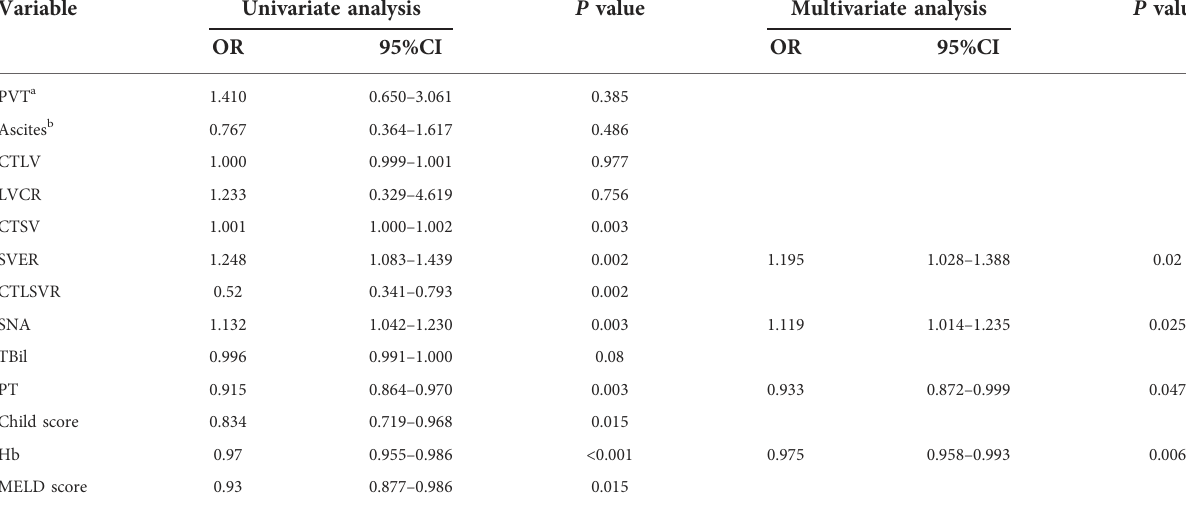
TABLE 2 Univariate and multivariate logistic regression analysis of bleeding in